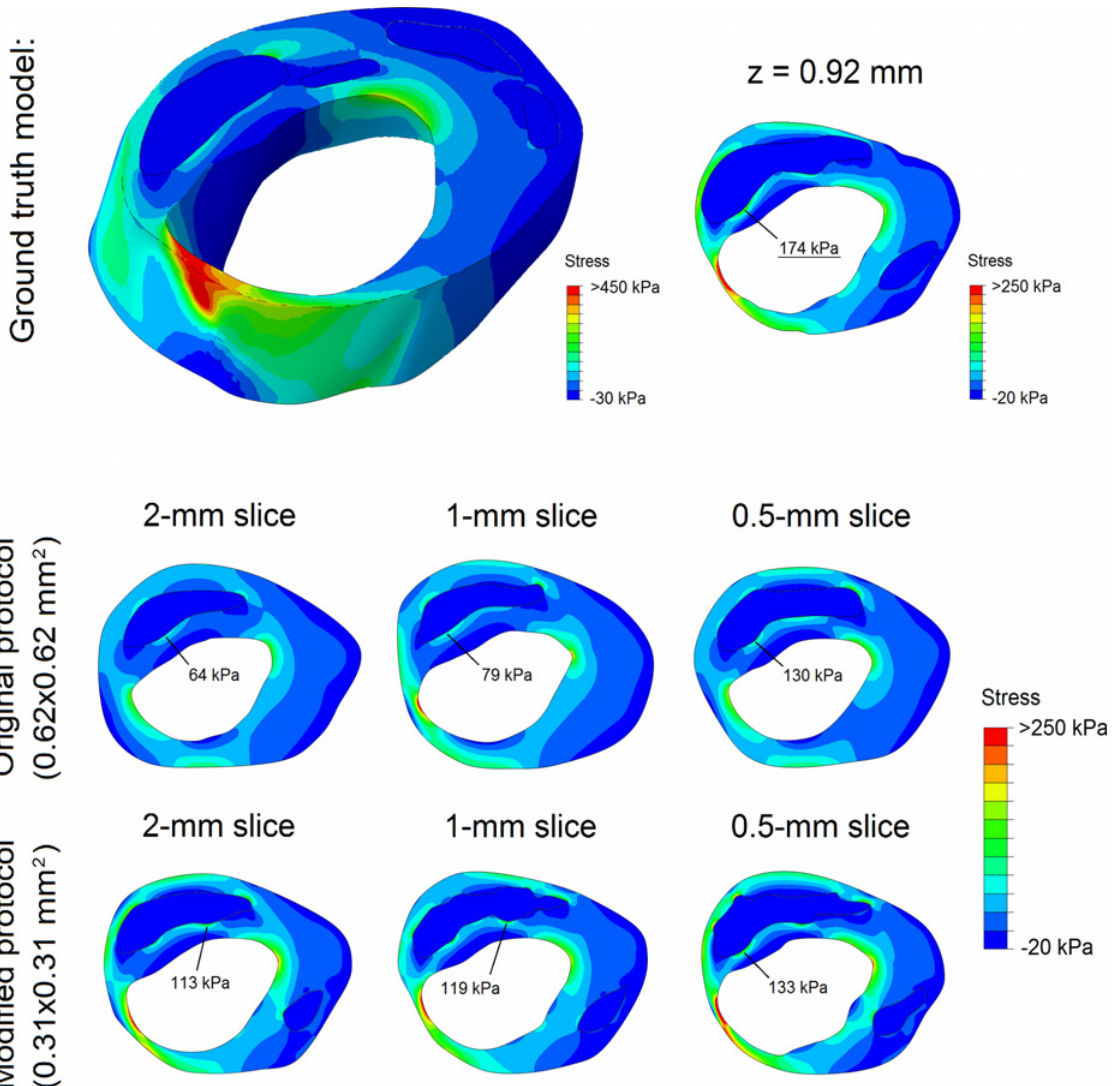
Fig 6. Stress distribution in an example 3D ground truth model (top row) and the stress distributions in its 6 2D MRI segmentation models (middle and bottom rows). The location and magnitude of the peak cap stress is indicated in each model.